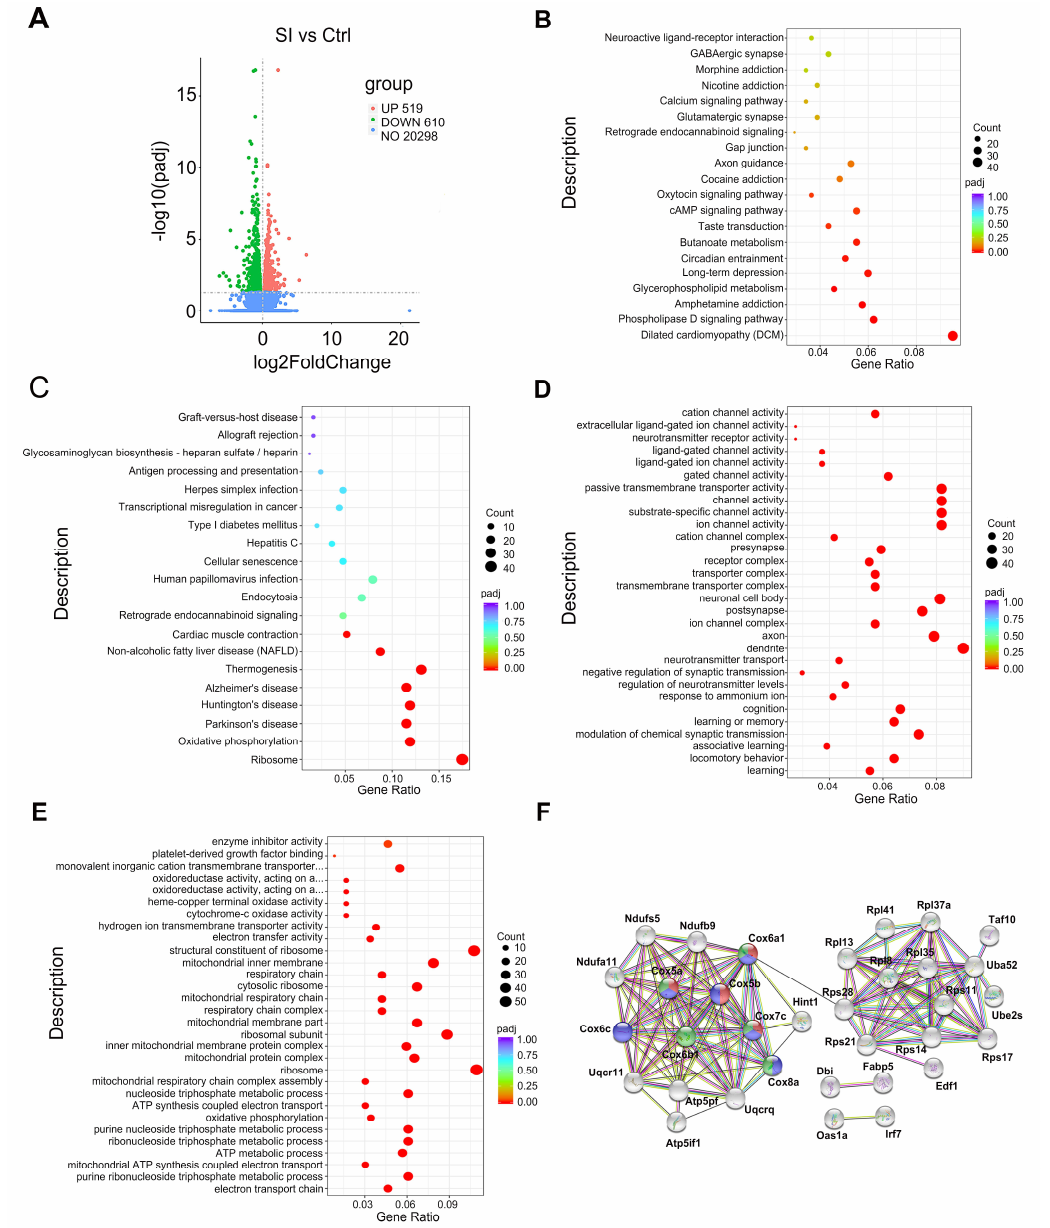
Figure 3. The effect of adolescent social isolation on the transcriptional patterns in the NAc: ( A ) volcano plots for differential expression genes. Genes that are upregulated are shown in red plots, while genes that are downregulated are illustrated in blue plots; ( B , C ) the KEGG analysis of the upregulated DEGs and downregulated DEGs in isolated female rats; ( D , E ) the GO analysis of the upregulated DEGs and downregulated DEGs; ( F ) analysis of the PPI network of the top 100 downregulated genes in the isolated rats. The nodes represent the downregulated genes in the PPI network, and the line colour indicates the type of interaction evidence (minimum required interaction score = 0.70); Ctrl indicates control; SI indicates social isolation.